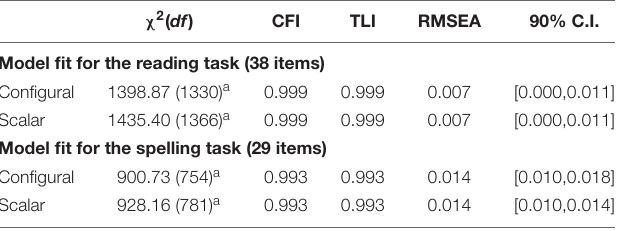
TABLE 3 | Model fit information for the reading and spelling